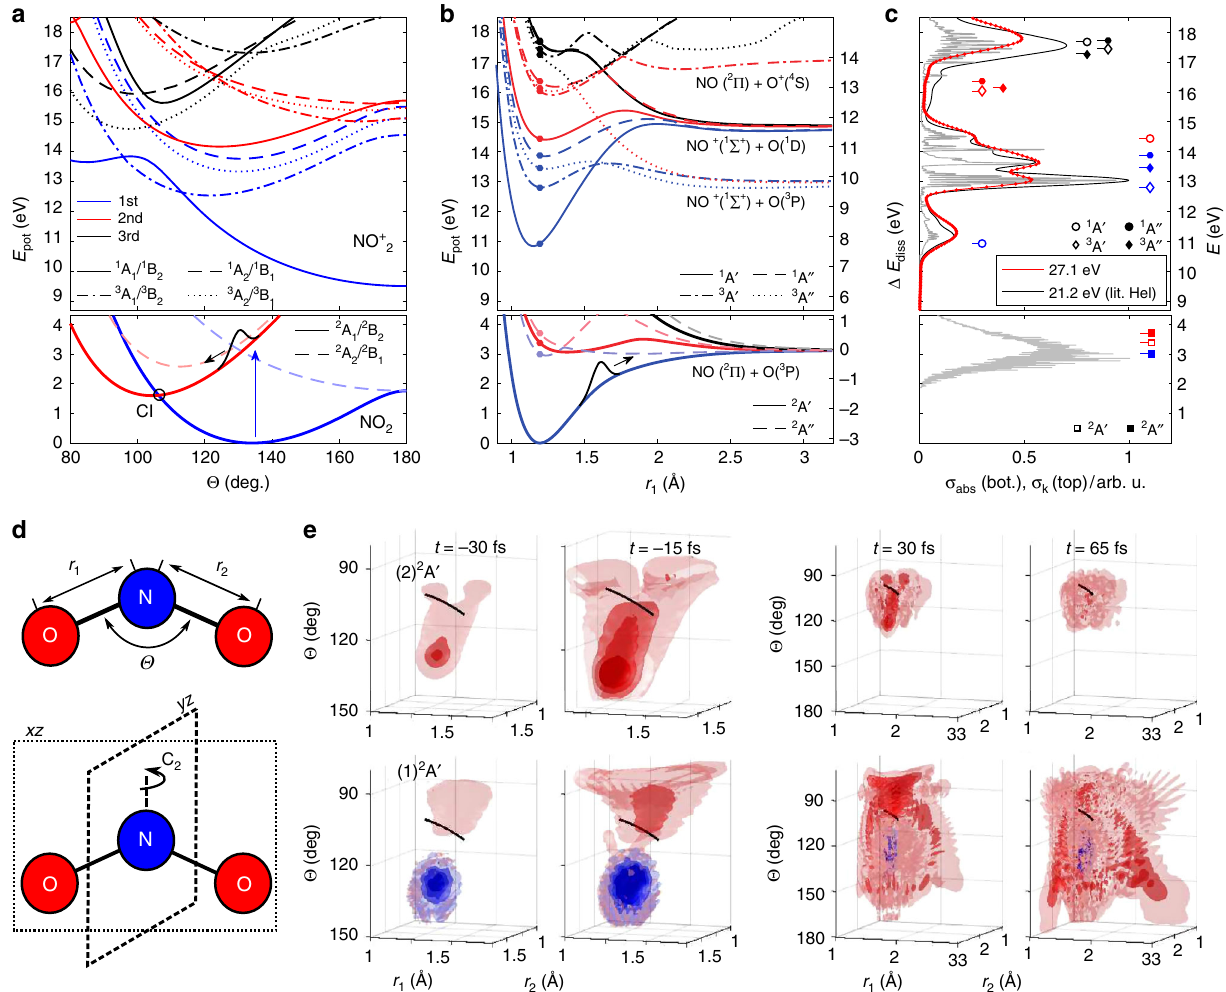
Fig. 2 Electronic structure and dynamics of NO 2 . a Adiabatic potential energy curves as a function of the bond angle Θ . The calculations are performed for ¼ 1 : 193 Å in C equal bond lengths r 1 ¼ r 2 ¼ r exp 2v symmetry. The colors blue, red and black label the lowest, second lowest and third lowest potential- eq energy surfaces of each symmetry type de fi ned by the nature of the line (full, dashed, dash-dotted, dotted), as indicated in the legend. b Same curves as function of r 1 , calculated in C s symmetry, with r 2 and Θ set to the experimental equilibrium values. The energy axis on the right-hand side of this panel is given relative to the dissociation threshold. c Comparison between a high-resolution photoelectron spectrum (gray) 59 convoluted with the experimental energy resolution (black), the experimental photoelectron spectrum obtained in this work (red) and the calculated position of the individual photoelectron bands according to the curves from b . In the same panel (bottom part) a UV-absorption spectrum 60 (gray curve) is compared to b (square markers, colored according to b ). d The coordinate conventions used throughout this article. e Time slices from the WP calculation described in the text and Supplementary Note 1; the top fi gures show the WP density on the adiabatic excited state and the lower row of fi gures shows the population change of the adiabatic ground-state. The isodensity coloration is blue for a depletion of initial population and red for a population gain. The black line depicts the seam of